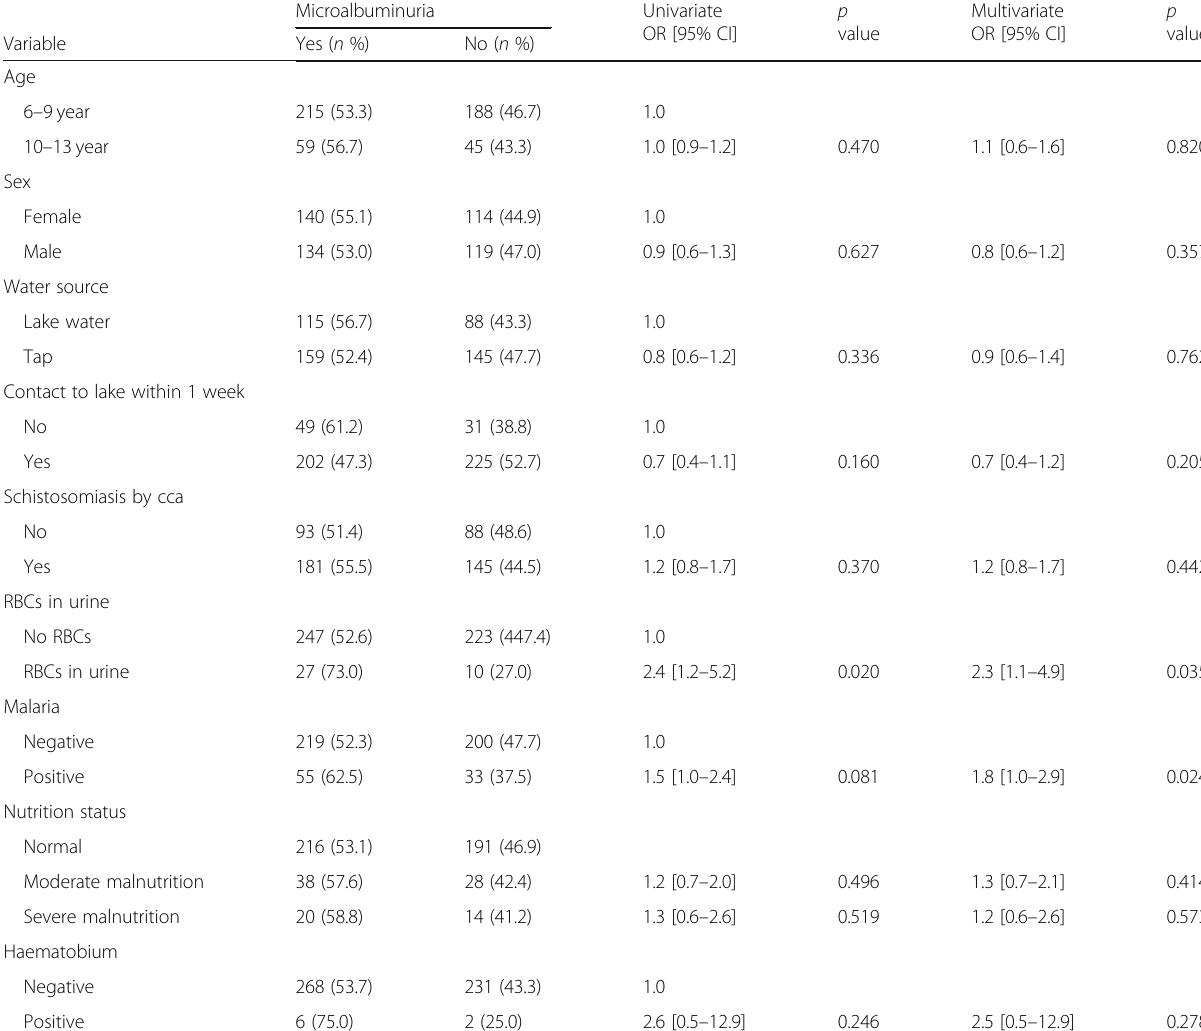
Table 4 Factors associated with